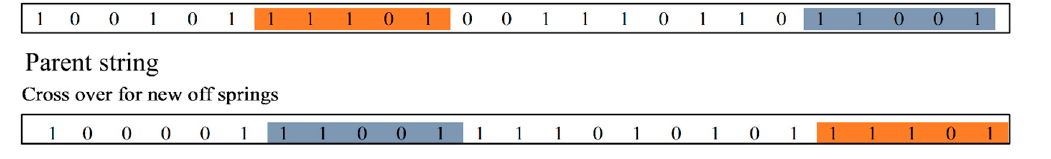
Figure 7. Crossover in a GA.